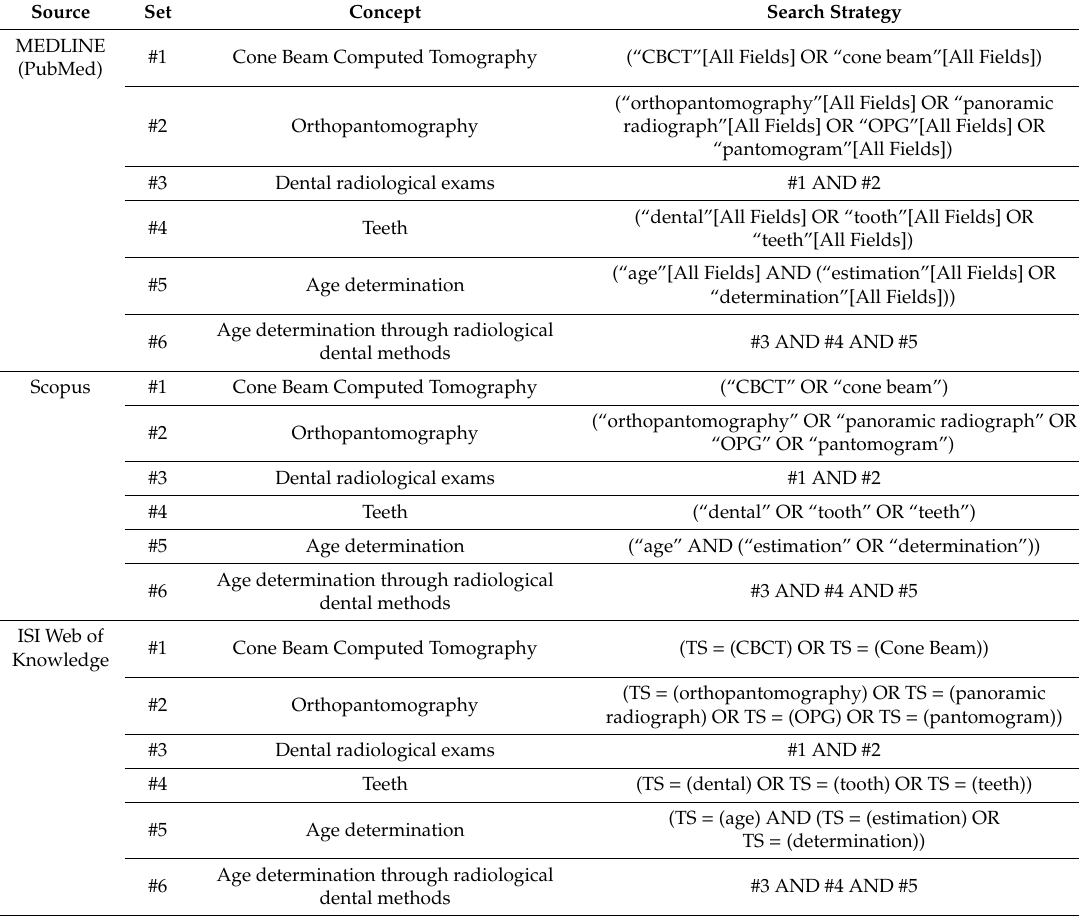
Table 2. Search strategy for articles comparing the accuracy of dental methods for age estimation, both with CBCT and OPG